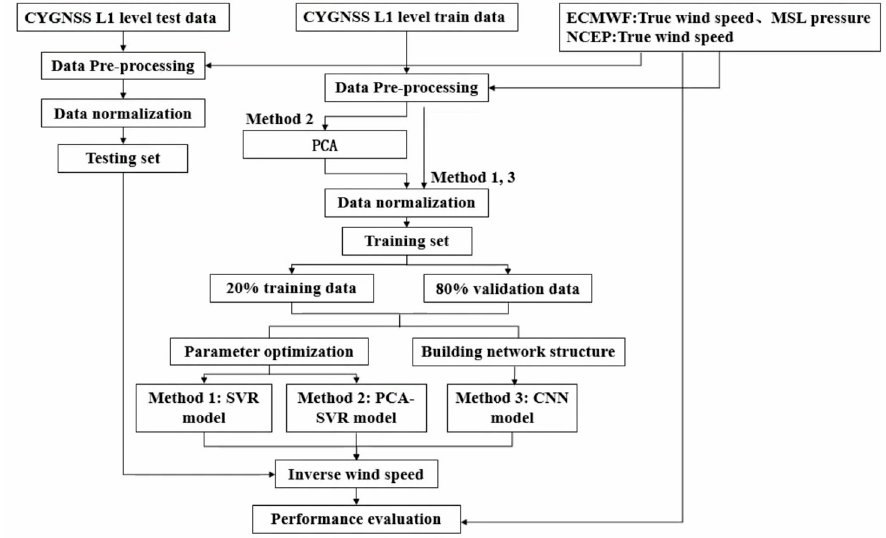
Figure 3. High wind speed inversion process based on machine learning.